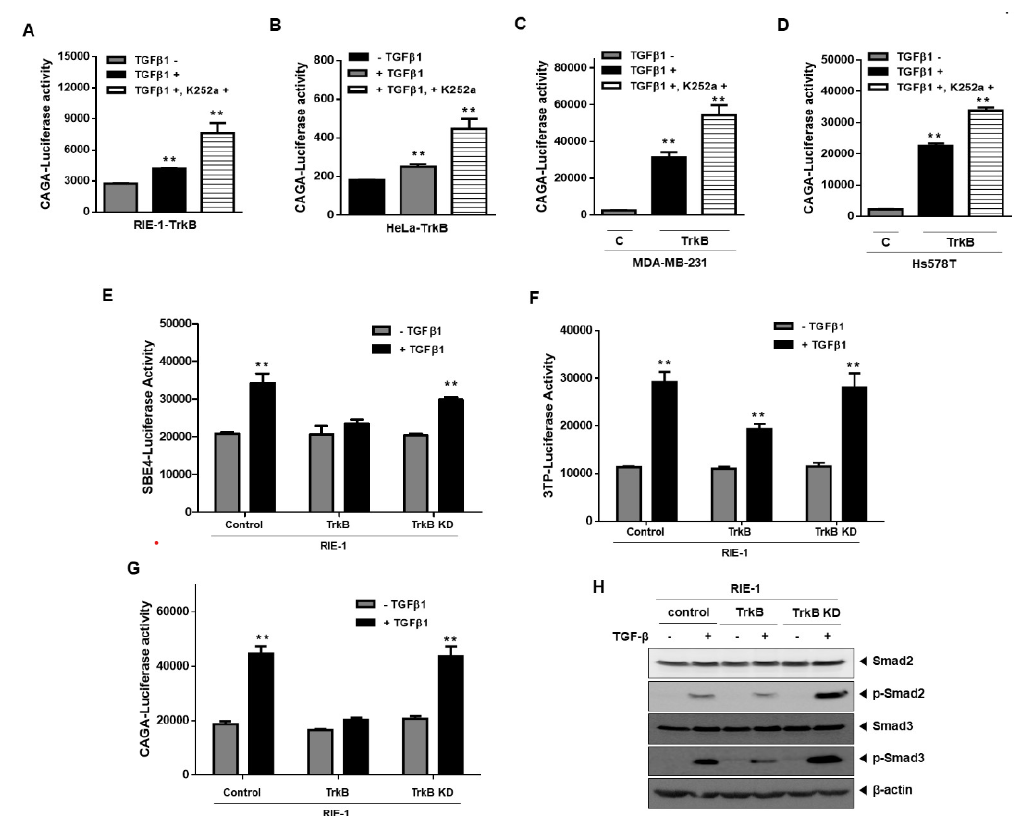
Figure 2. The activation of TrkB kinase required for suppression of the growth inhibitory property of TGF- β. ( A – D ) Luciferase reporter assay of SMAD3-dependent (CAGA) 12 -Luc in RIE-1-TrkB cells ( A ), HeLa-TrkB cells ( B ), TrkB-transfected MDA-MB-231 cells ( C ), and TrkB-transfected Hs578T cells ( D